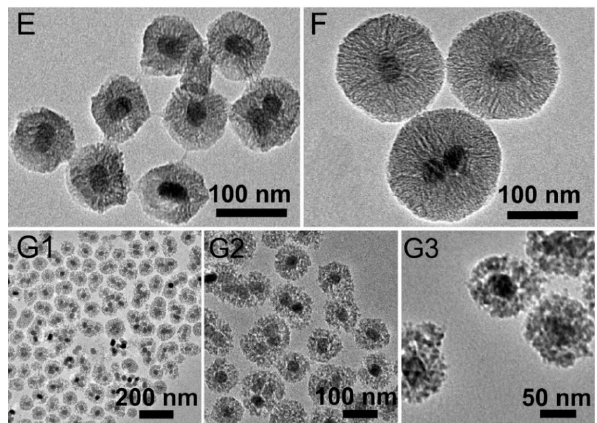
Figure 1. TEM images of ( A ) NaYF 4 :Yb,Er and ( B ) NaYF 4 :Yb,Er@NaYF 4 :Yb,Nd UCNPs. TEM images of UCNP@mSiO 2 ( R 1 = 15 nm) with different mesoporous silica sizes: ( C ) D = 5 nm, ( D ) 15 nm, ( E ) 30 nm, and ( F ) 60 nm. (G1–G3) TEM images of UCNP@mSiO 2 -Au NPs ( R 1 = 15 nm, D = 30 nm, Z = 2–4 nm) at different magnifications.